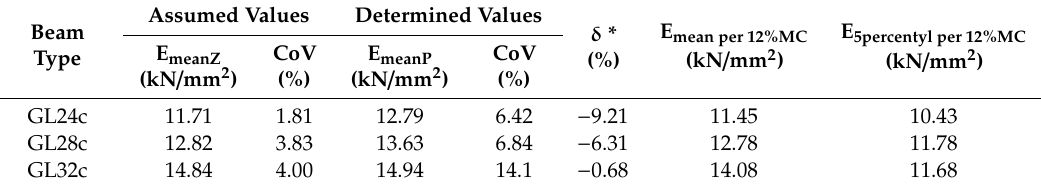
Table 2. Elastic properties of the designed